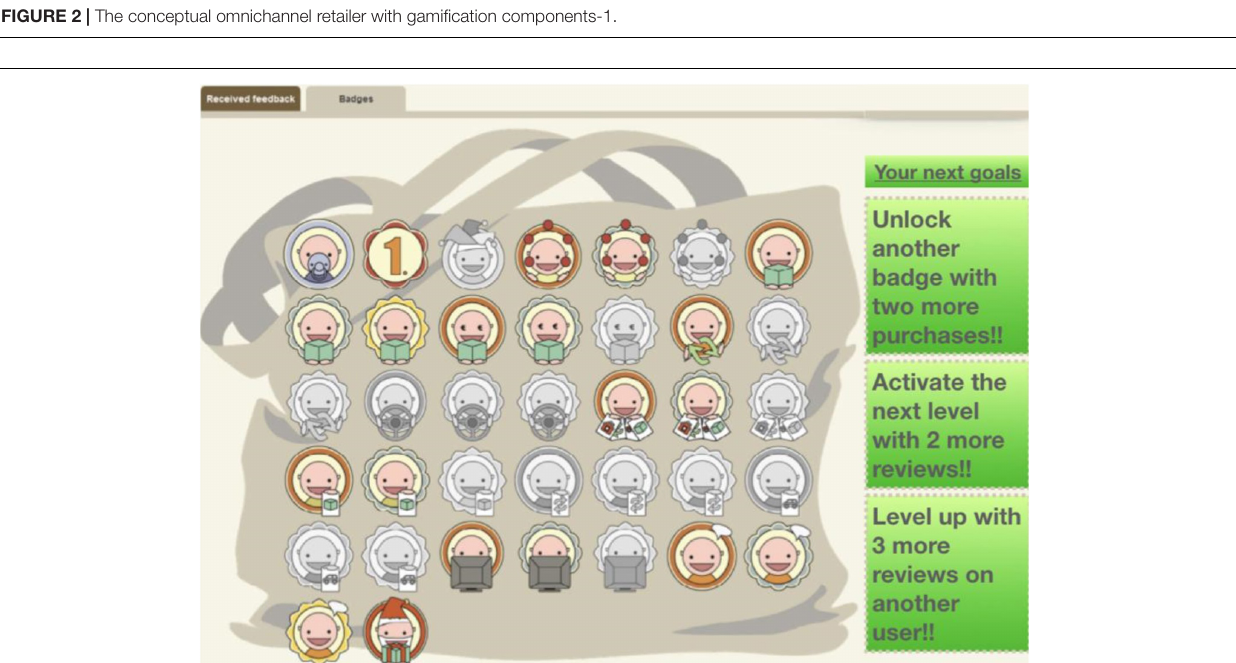
FIGURE 2 | The conceptual omnichannel retailer with gamification components-1.